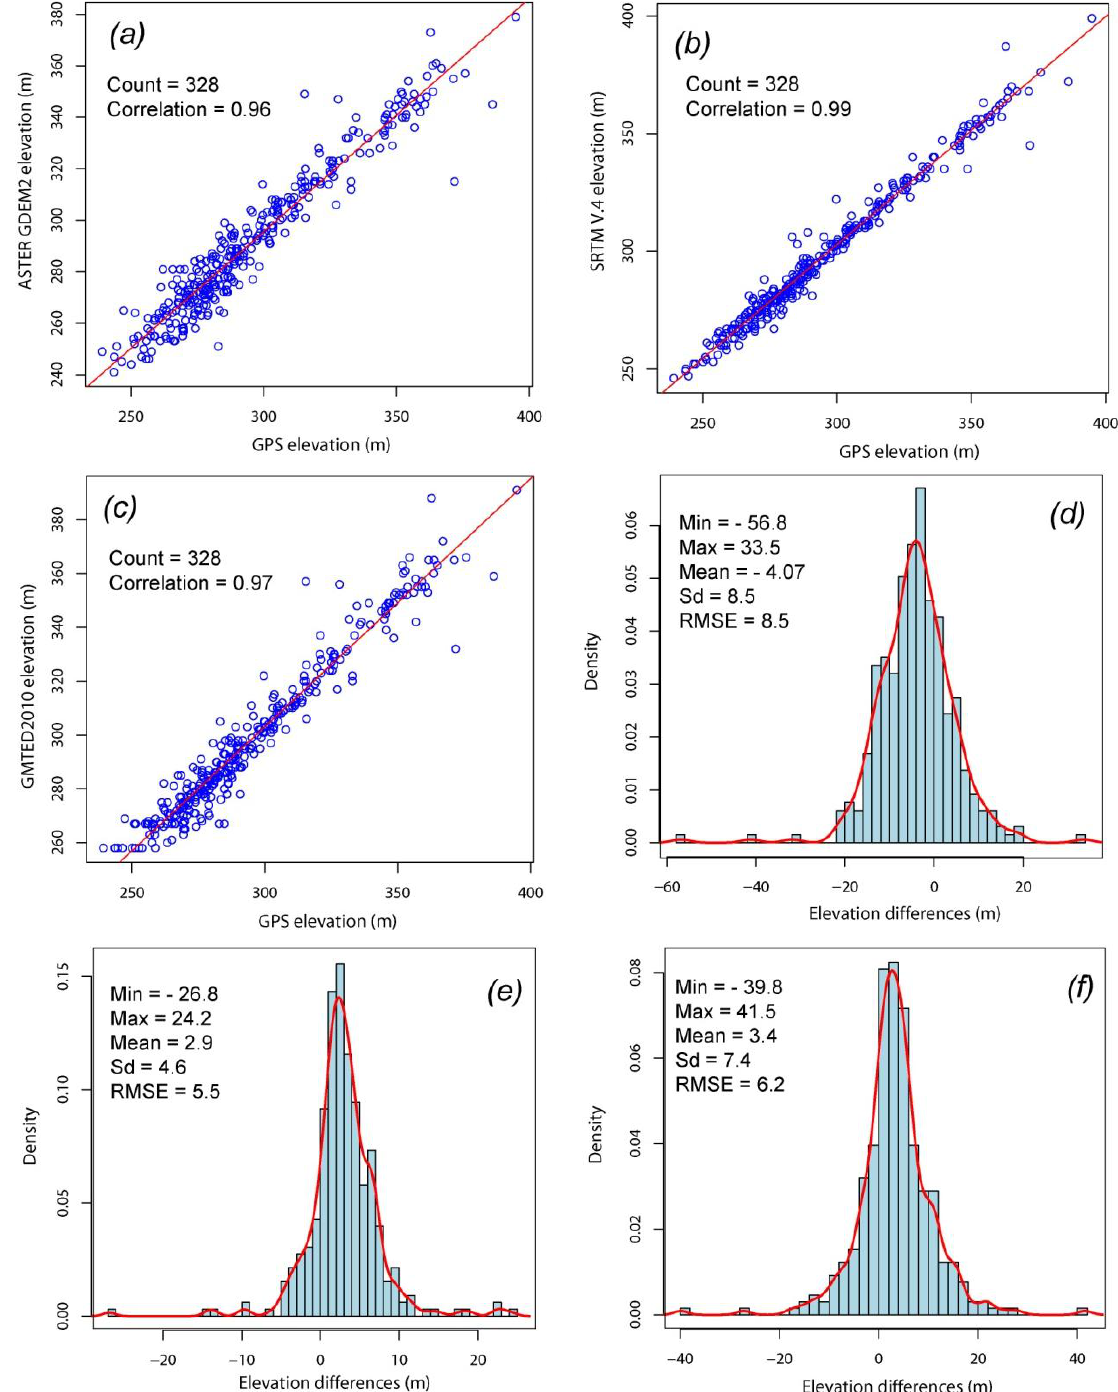
Figure 7. Summary statistics for Anaguid test site. Scatter plots of GNSS elevations vs. ( a ) ASTER GDEM2, ( b ) SRTM v4.1 and ( c ) GMTED2010. The fine red line stands for the line of perfect fit. Histograms of elevation errors and relevant descriptive statistics. ( d )